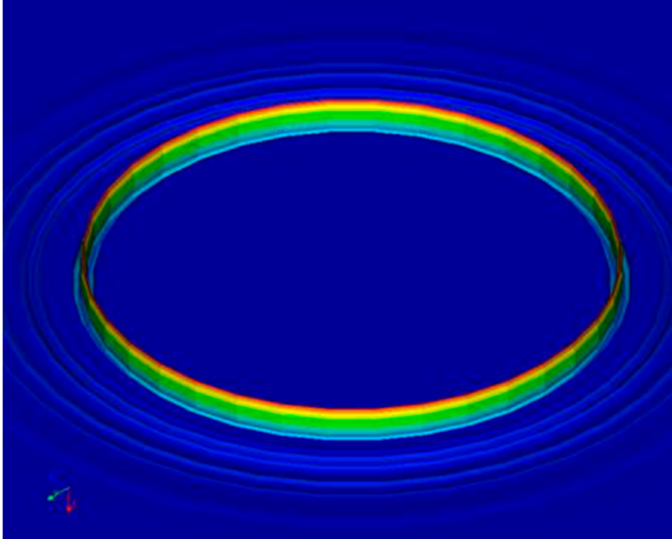
Figure 1. A view of a graded sedimentary solid from above. This shows a vibration wavelet travelling outward from the central point of excitation. Note the small advanced ripples and a lack of any disturbance behind the peak of the largest, slowest